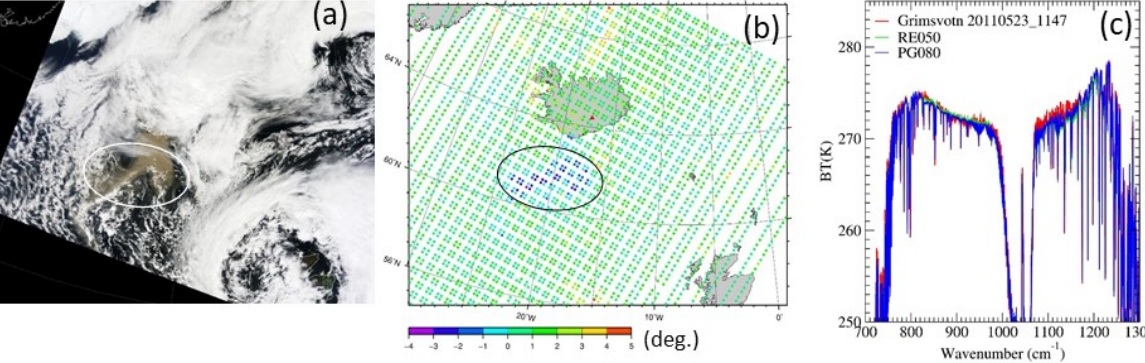
Figure 12. Grímsvötn VAC on 23 May 2011, shown in a MODIS true-color image taken at 12:05UTC (a) , (cid:49) TB split from IASI measurements at 11:47UTC (b) , and the BTS of the IASI pixel at (lat, long) = (61.390 ◦ N, 21.484 ◦ W) (red) (c) . The results of BTS simulations using RE050 (green) and PG080 (blue) are also shown in (c)